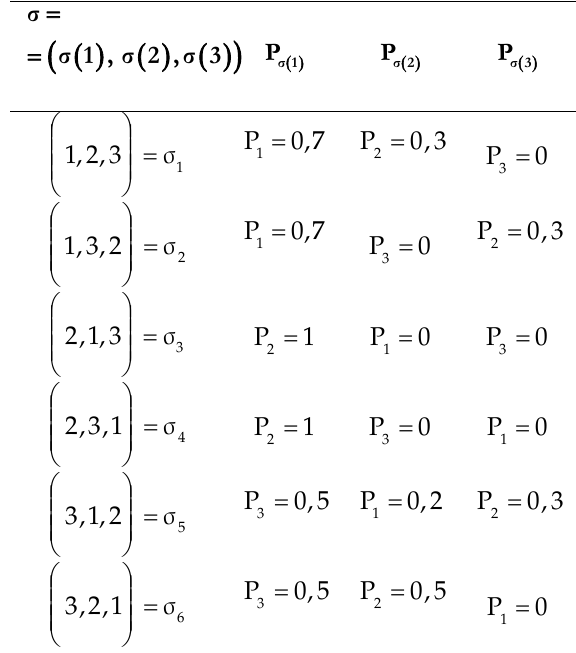
Table 2. Associated probability class -